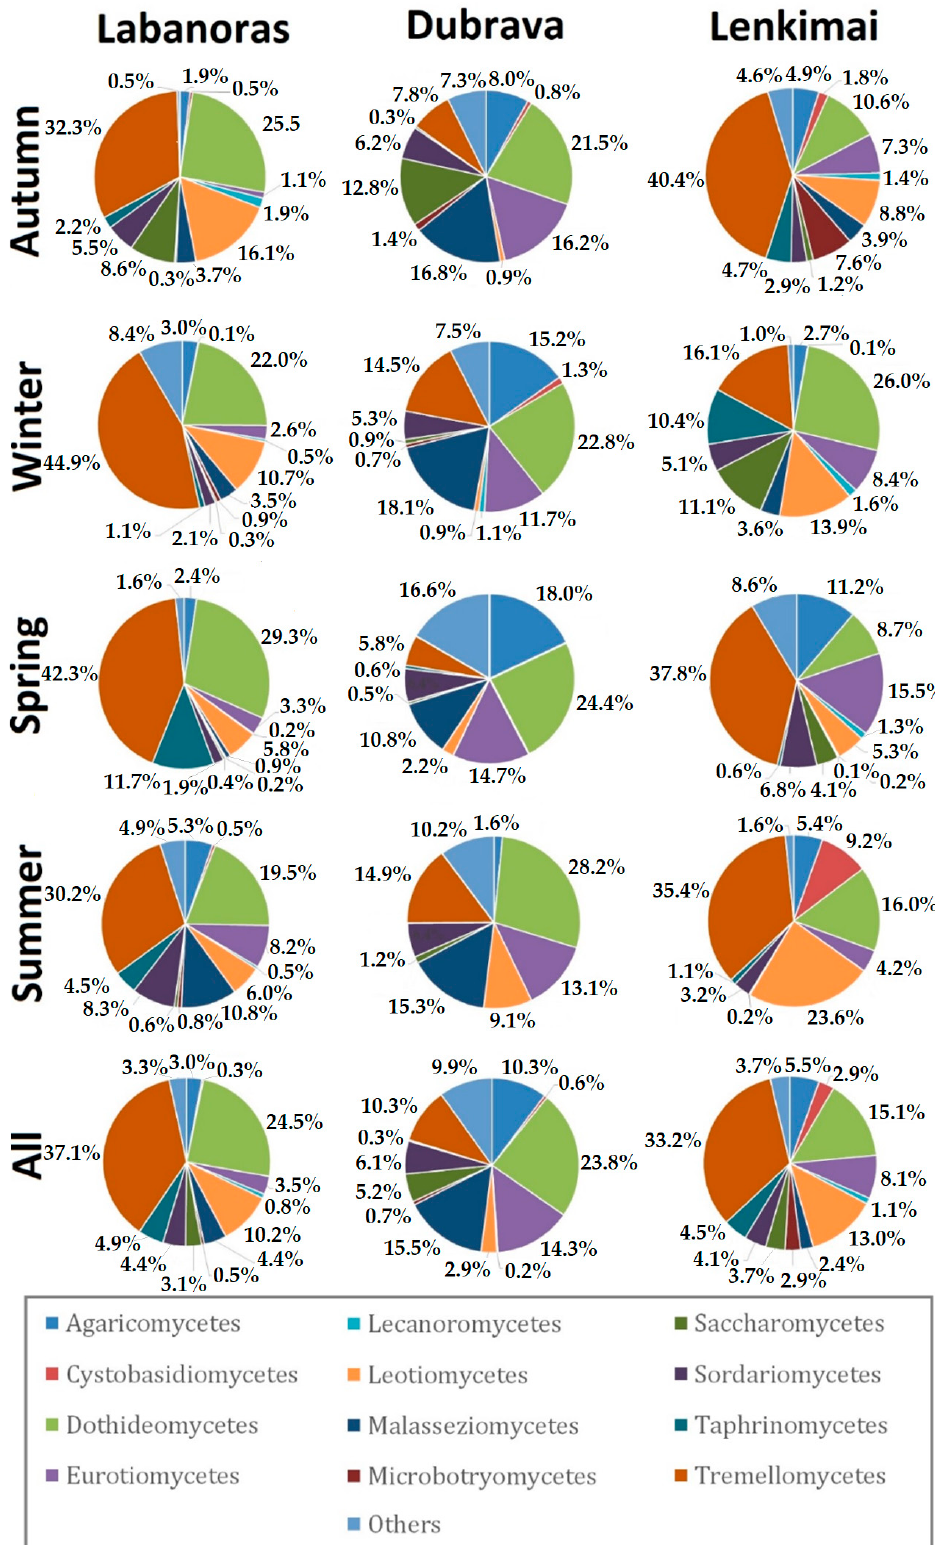
Figure 5. Composition and relative abundance of different fungal classes in trapped fungal spore samples from the three study sites (Labanoras, Dubrava, Lenkimai) and different seasons of the year (Autumn, Winter, Spring, and Summer). Others represent fungal classes for which the relative abundance was <1%.